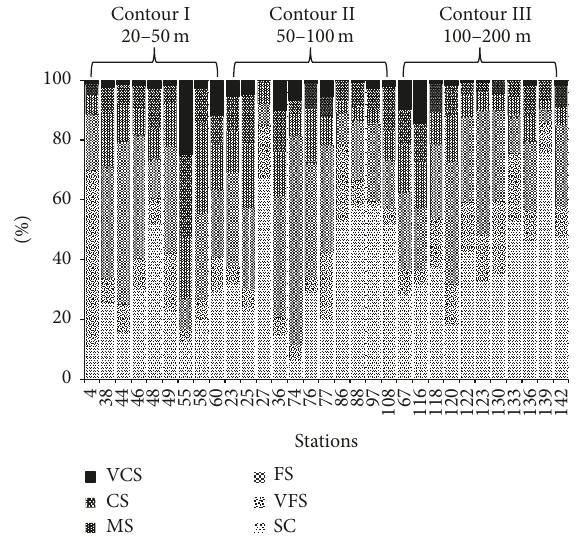
Figure 4: The particle size distribution of 31 stations sampled at Sarawak EEZ. VCS: very coarse sand (1000 𝜇 m); CS: coarse sand (500 𝜇 m); MS: medium sand (250 𝜇 m); FS: fine sand (125 𝜇 m); VFS: very fine sand (63 𝜇 m); SC: silt-clay ( < 63 𝜇 m).